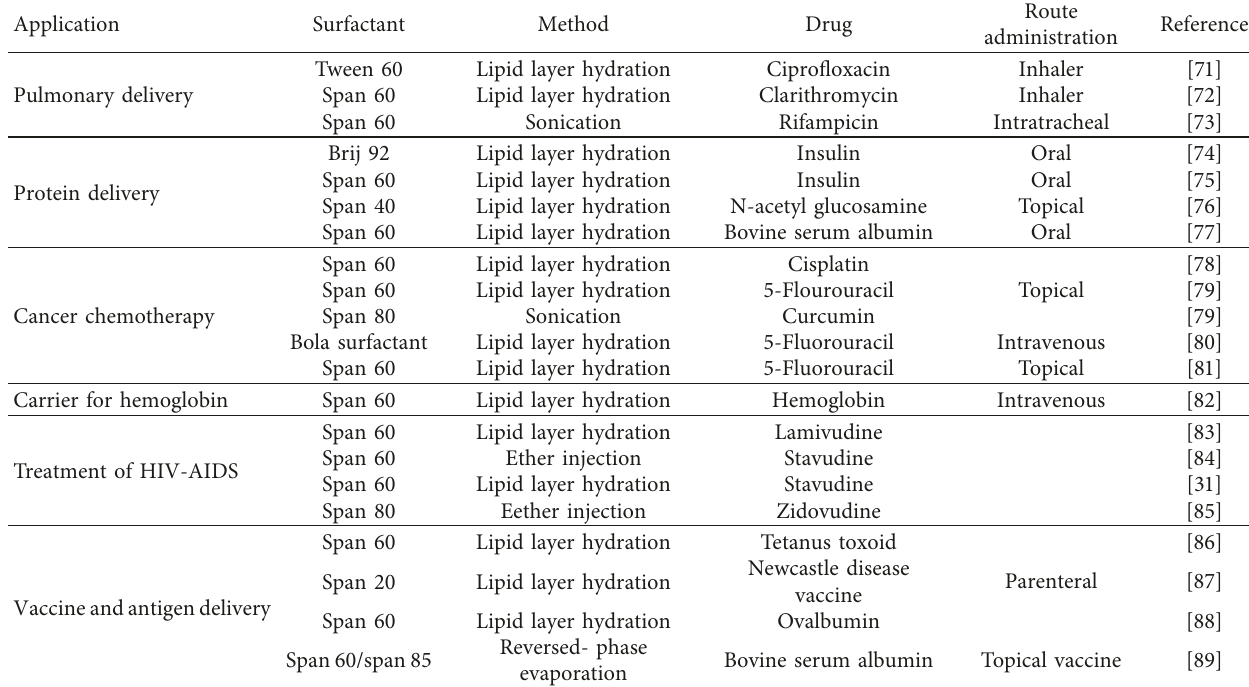
Table 1: Recent studies in drug delivery using